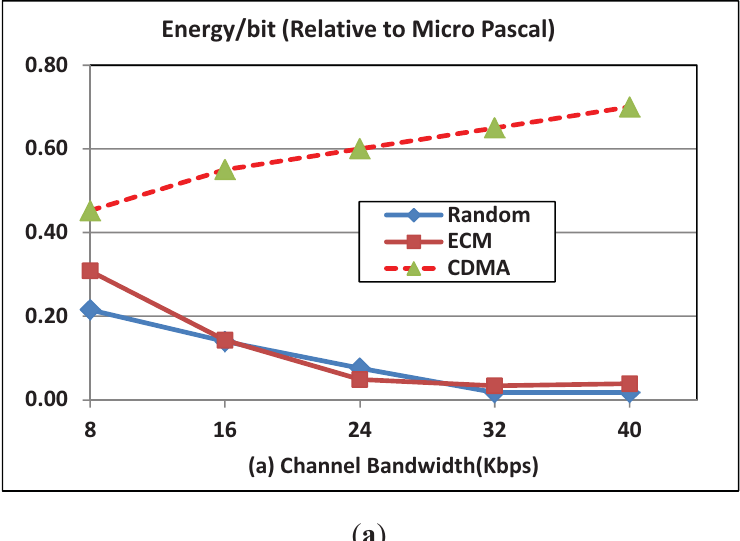
Figure 5. ( a ) Energy per transmitted bit; ( b ) Throughput for OFDMA and CDMA with